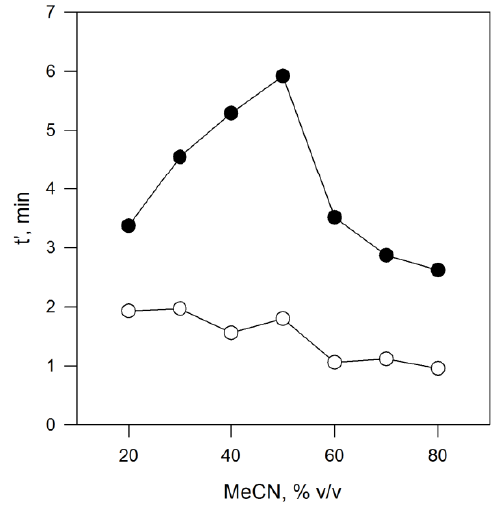
Figure 5. Reduced migration times ( t ′) measured in WAR-imprinted (filled circles) and non-imprinted (filled circles) capillaries prepared with RAFT initiator by using different percentages of acetonitrile added to 5 mmol∙L −1 phosphate buffer, pH 6.4.